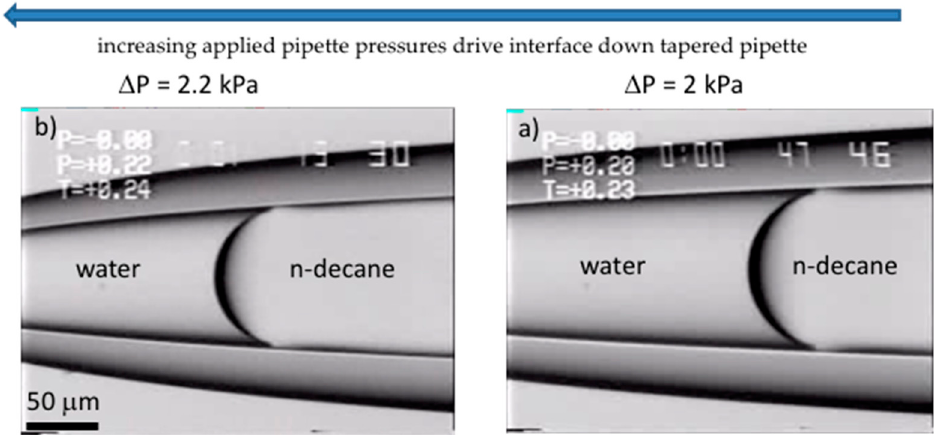
Figure 8. Equilibrium interfacial tension for the simple oil-water system. Shown are video-micrographs from an experiment where n-decane filled the micropipette and water was placed in the microchamber. ( a ) (right-hand micrograph) As in Figure 5, the (partially) oil-filled micropipette was inserted into the water under positive applied pipette pressure ∆ P of 2 kPa to give an interface meniscus in the pipette taper with a diameter ~100 µ m. The applied positive pressure was increased to ( b ) 2.2 kPa, and the oil-water interface was moved to a new position with a smaller diameter of 93 µ m. This was repeated to obtain the advancing and receding meniscus positions and corresponding radii used to plot the data in Figure 9.